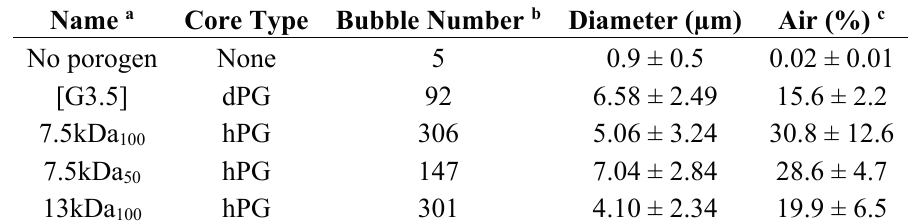
Table 1. Overview of the different core type porogens and their air-in-solution values. All porogens were used at 1 mM concentration. Name